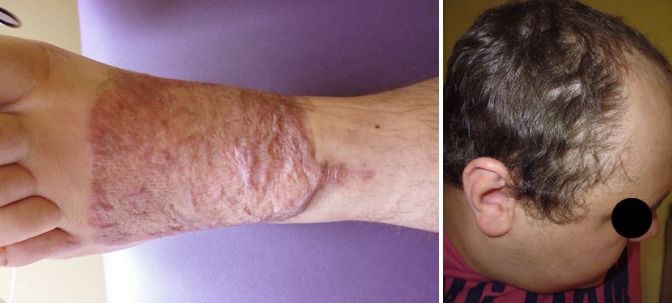
Five month post-op